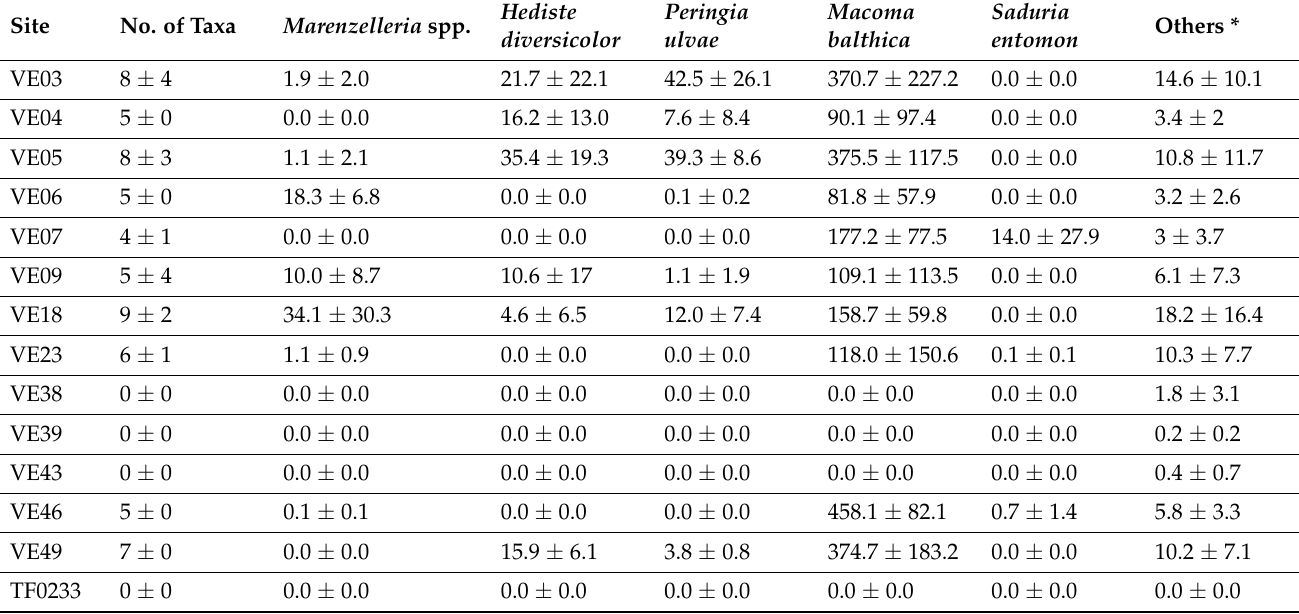
Table A2. Average ( ± SD) number of taxa and biomass (g. m − 2 ) at the sampling sites of the dominant taxa present ( n = 2 for sites VE49, n = 3 for TF0233, VE09, VE38, VE39, VE43; n = 4 for VE04, VE06, VE07, VE18, VE23, VE46 and n = 5 for VE03 and